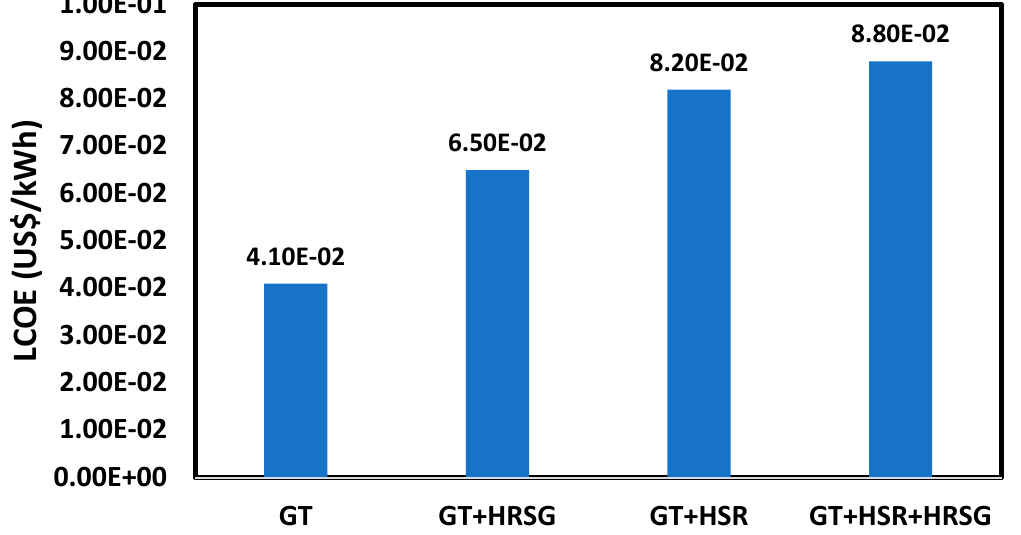
Figure 17. The levelized cost of electricity (LCOE) of four types of GT, GT + HRSG, GT + HSR, and GT + HRSG + HSR.